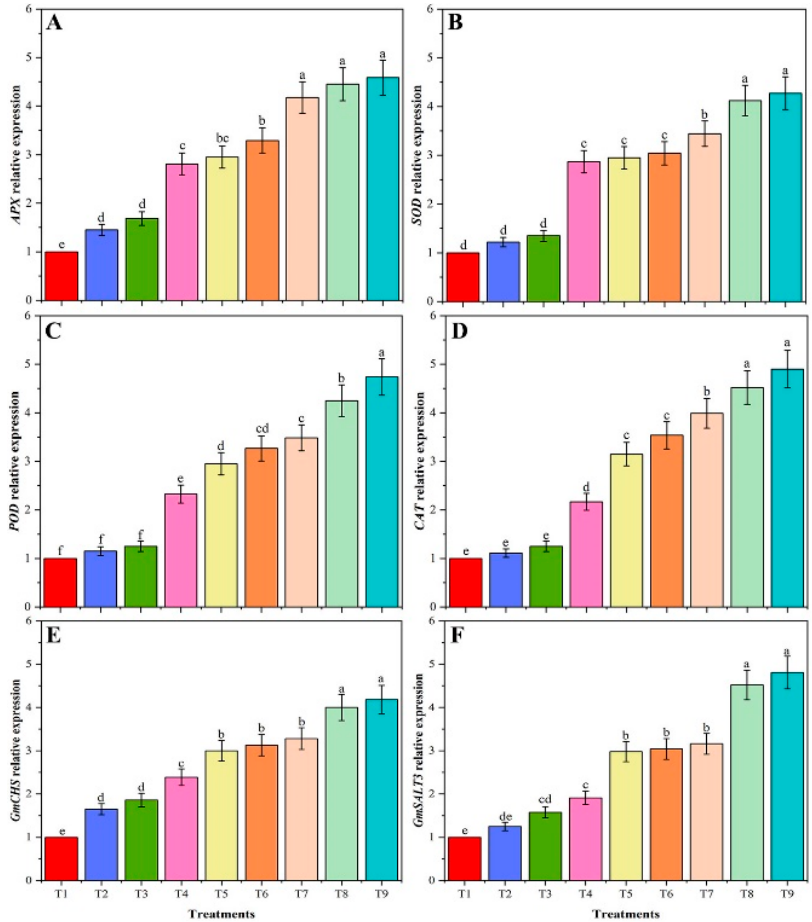
Figure 9. Expression levels of APX ( A ), SOD ( B ), POD ( C ), CAT ( D ), GmCHS ( E ) and GmSALT3 ( F ) genes of un-amended and amended soybean plants with chitosan modified and as-is biochar under saline conditions. Data are shown as the mean ± standard deviation (n = 3).